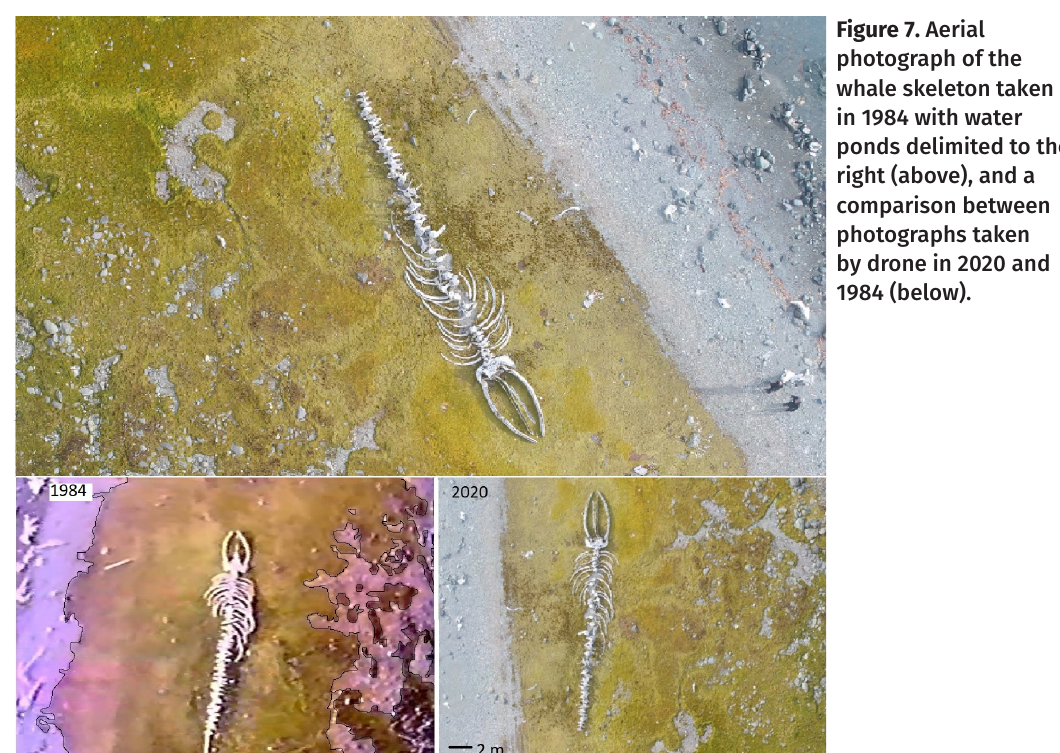
Figure 7. Aerial photograph of the whale skeleton taken in 1984 with water ponds delimited to the right (above), and a comparison between photographs taken by drone in 2020